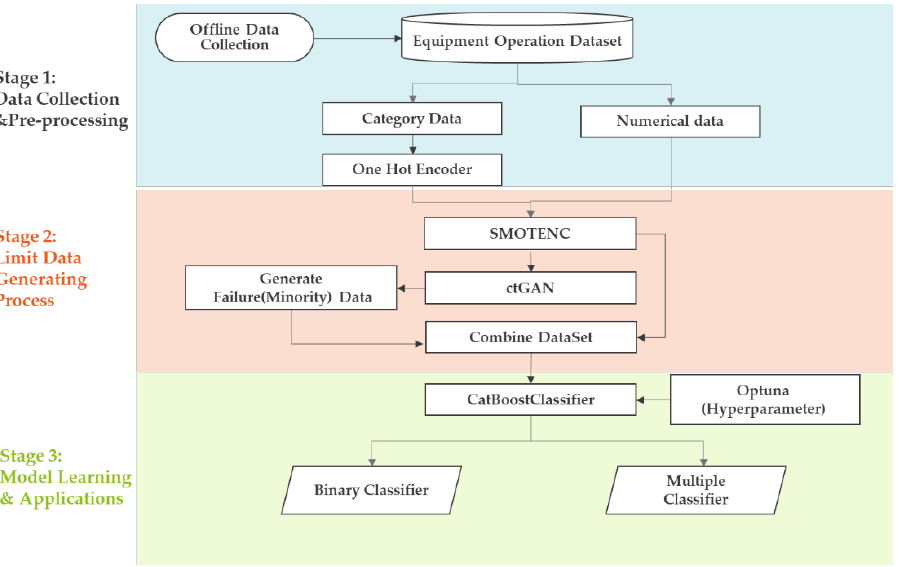
Figure 1. Framework of the proposed SmoteNC—conditional tabular generative adversarial network (ctGAN) system.